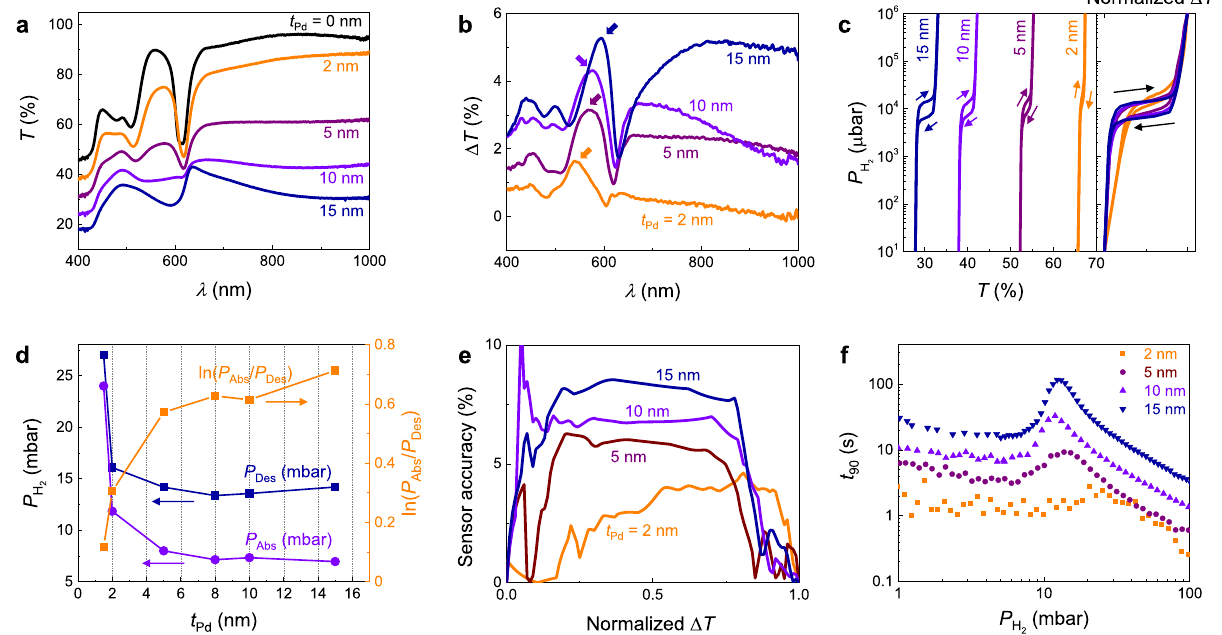
= 0 mbar) and b optical transmission changes Δ T ( λ ) 2